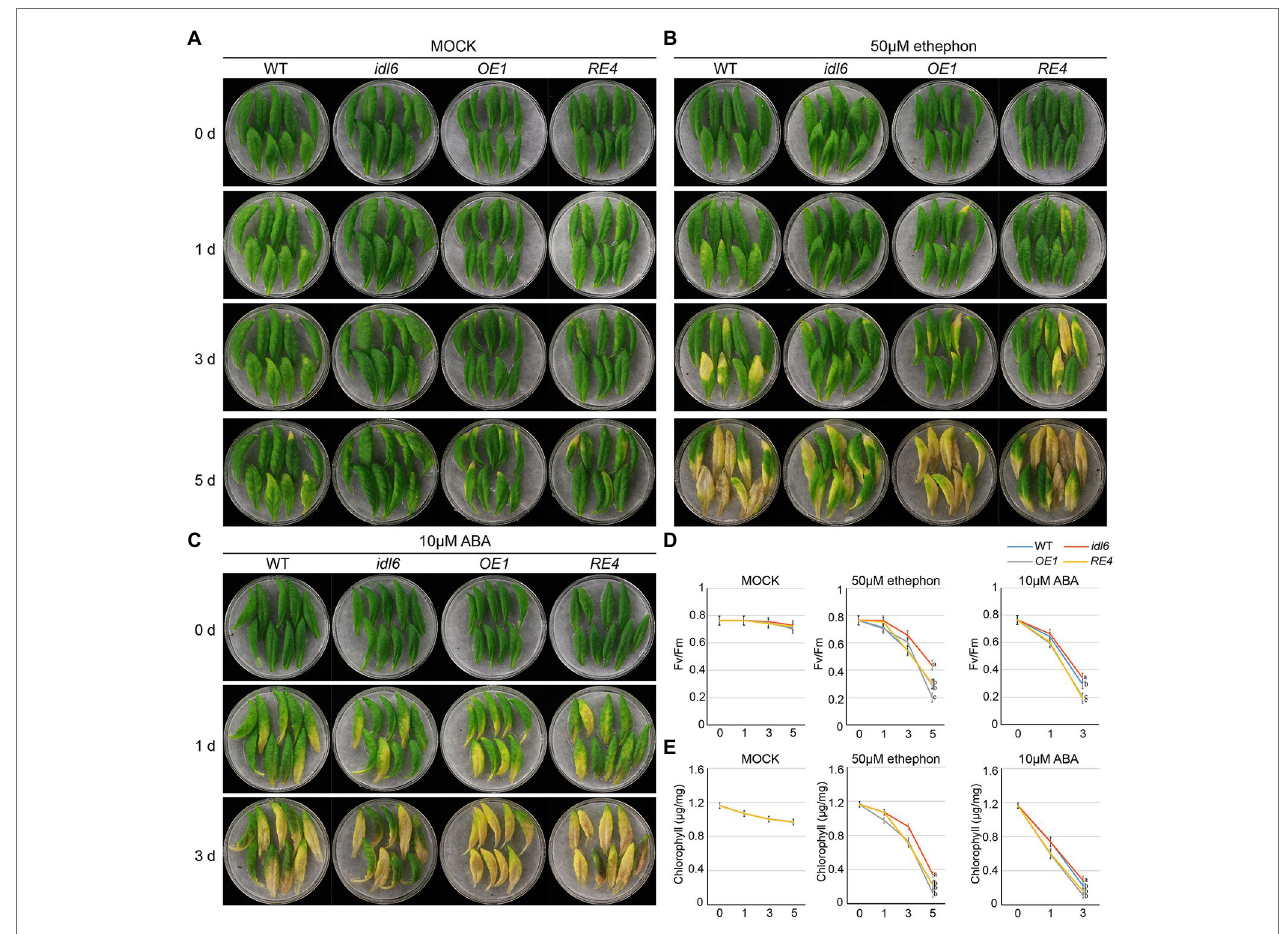
FIGURE 7 | Senescence induced by ABA and ethylene on detached leaves of Arabidopsis . The 7th, 8th and 9th leaves of 6-week-old wild type, idl6 mutant, IDL6 OE plants and idl6 rescue plants were collected and treated by mock (A) , 50 μ M ethephon (B) and 10 μ M ABA (C) . The images of leaves were taken before and 1 day, 3 days, and 5 days after treatments. (D) The Fv/Fm and (E) chlorophyll concentrations in hormone treated and untreated leaves. For all conditions, statistically significant had been performed by two-way ANOVA analysis. All treatments were performed for three